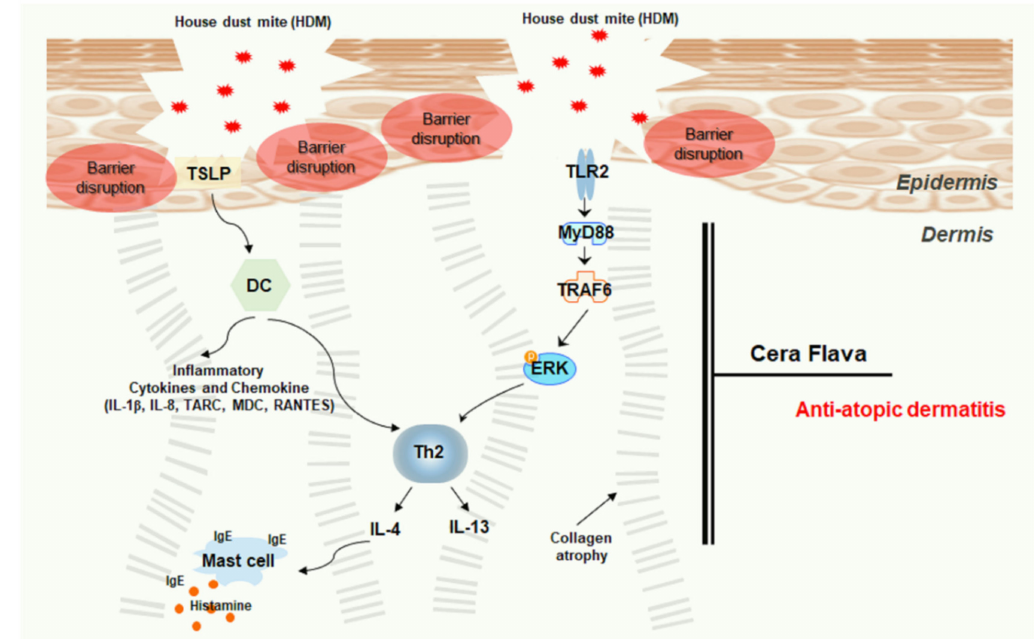
Figure 5. Schematic model of the effects of CF treatment on the HDM-induced AD mouse model. Upon HDM exposure, epithelial barrier disturbances, functional defects, and inflammatory cell infiltration were observed. The barrier-disrupted epidermis released abundant TSLP, which promotes cytokine/chemokine immune responses. CF treatment reduced AD severity, relieved AD-like symptoms, and attenuated inflammatory cell infiltration and cytokine/chemokine expression by controlling the TLR2/MyD88/TRAF6/ERK axis. CF alleviates AD by activating skin barrier function via immune